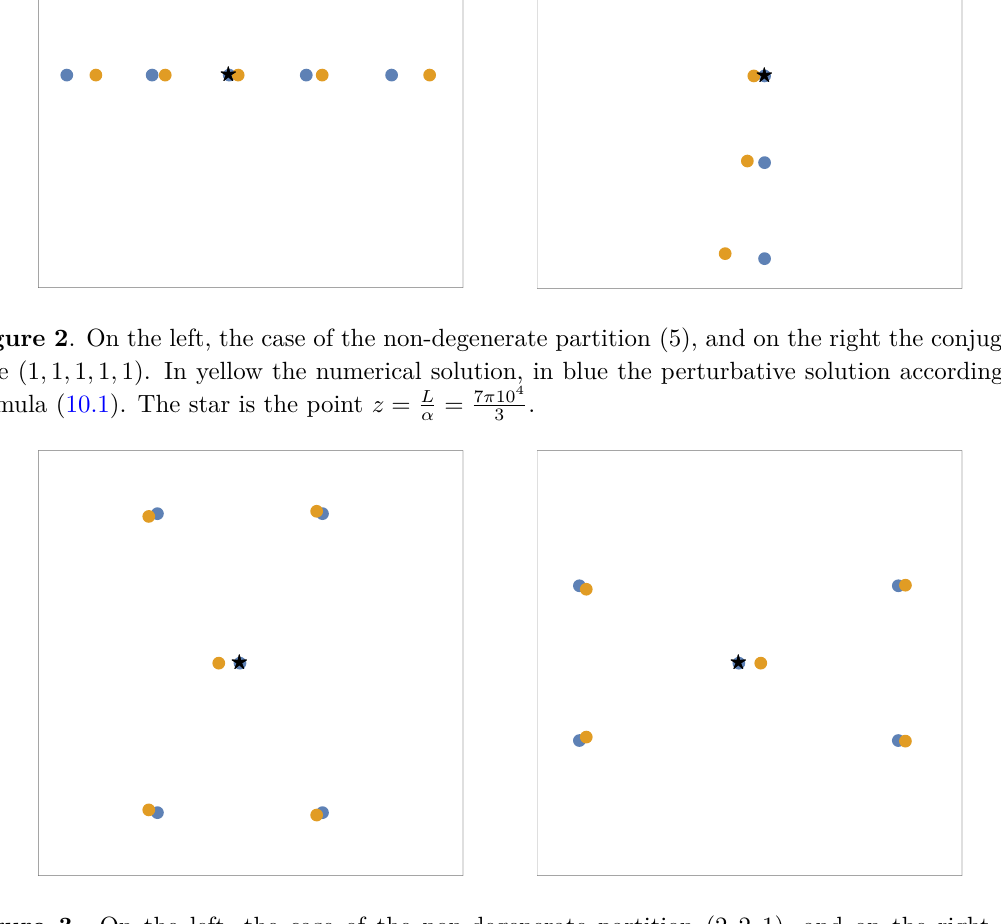
Figure 3 . On the left, the case of the non-degenerate partition (2 , 2 , 1) , and on the right the conjugate case (3 , 2) . In yellow the numerical solution, in blue the perturbative solution according to formula (10.1). The star is the point z = L